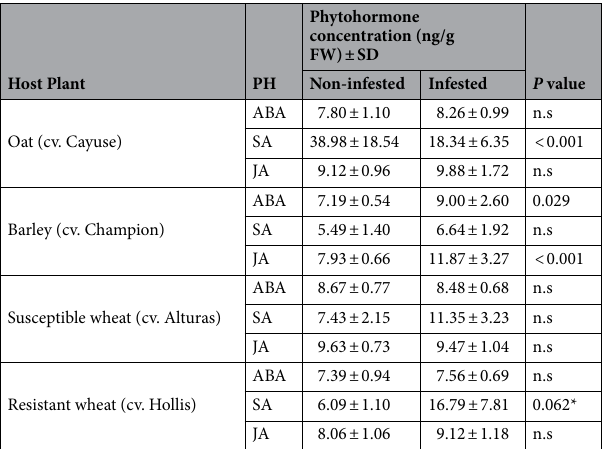
Table 1. Effect of infestation on the concentration of phytohormones in the host plant treatments. PH: Phytohormone, ABA: abscisic acid, SA: salicylic acid, JA: jasmonic acid. n.s.: Nonsignificant. *Nonsignificant but biologically relevant for